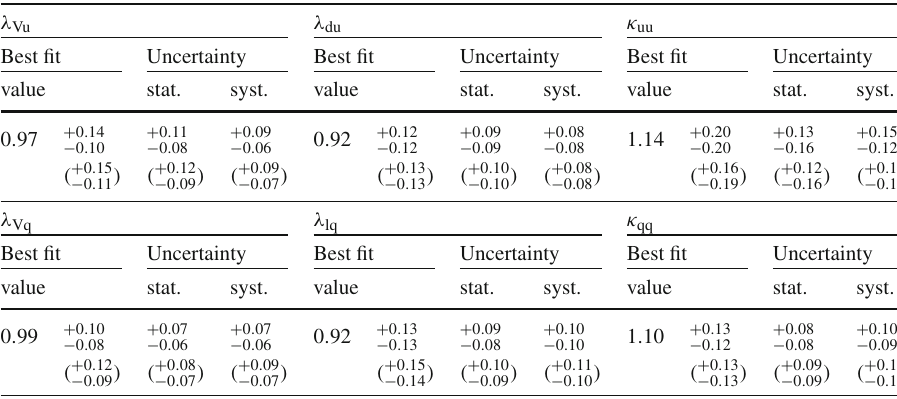
the corresponding p -value, with respect to the SM, assuming q is dis- tributedaccordingtoa χ 2